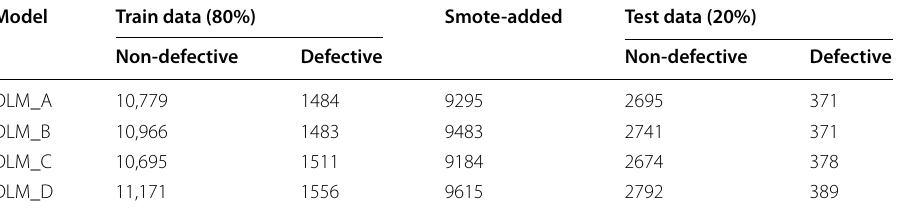
Table 11 Quantities of devices (defective and non-defective) used for training and testing plus the number of SMOTE-added devices for the minority class (defective)